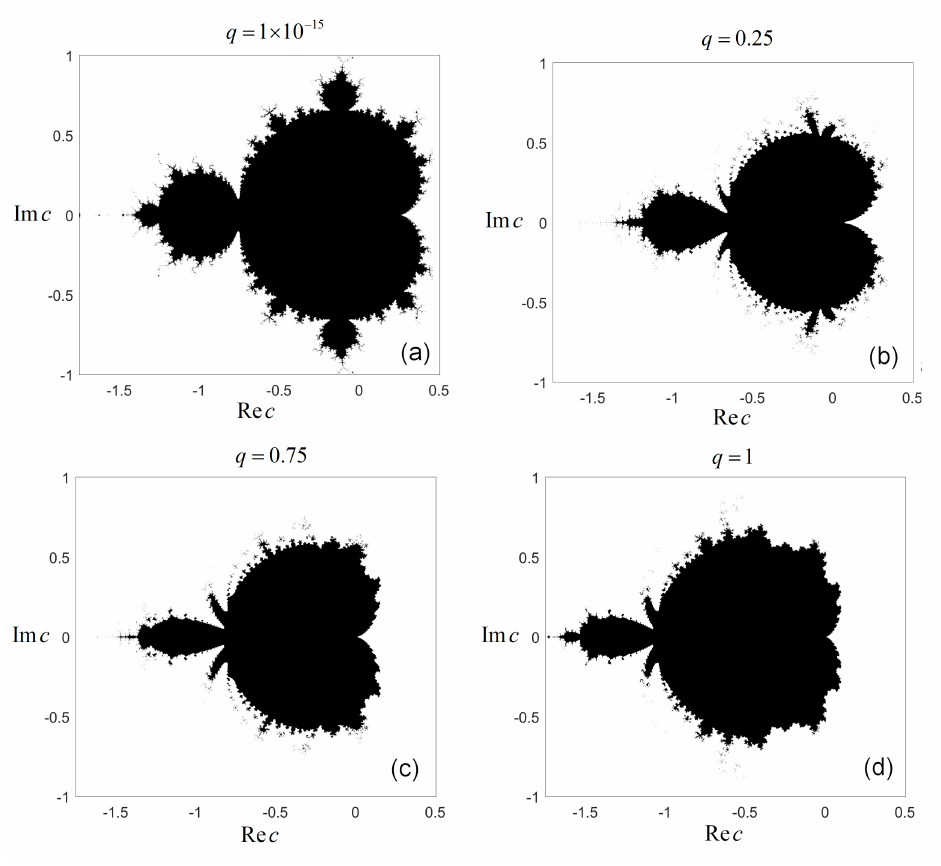
Figure 1. Four Mandelbrot sets of FO: ( a ) q = 1 × 10 − 15 ; ( b ) q = 0.25; ( c ) q = 0.75; ( d ) q =